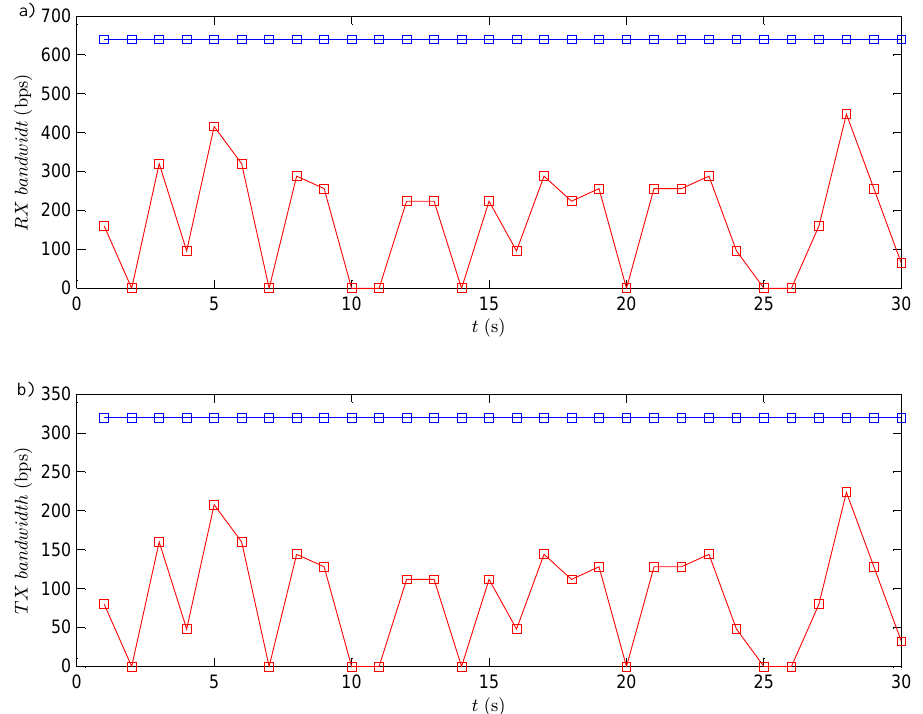
Figure 18. RF channel utilization. The blue square shows the discrete-time strategy; the red square represents the event-based strategy. ( a ) Bandwidth used in reception (from the robots to the controller); ( b ) bandwidth used in transmission (from the controller to the